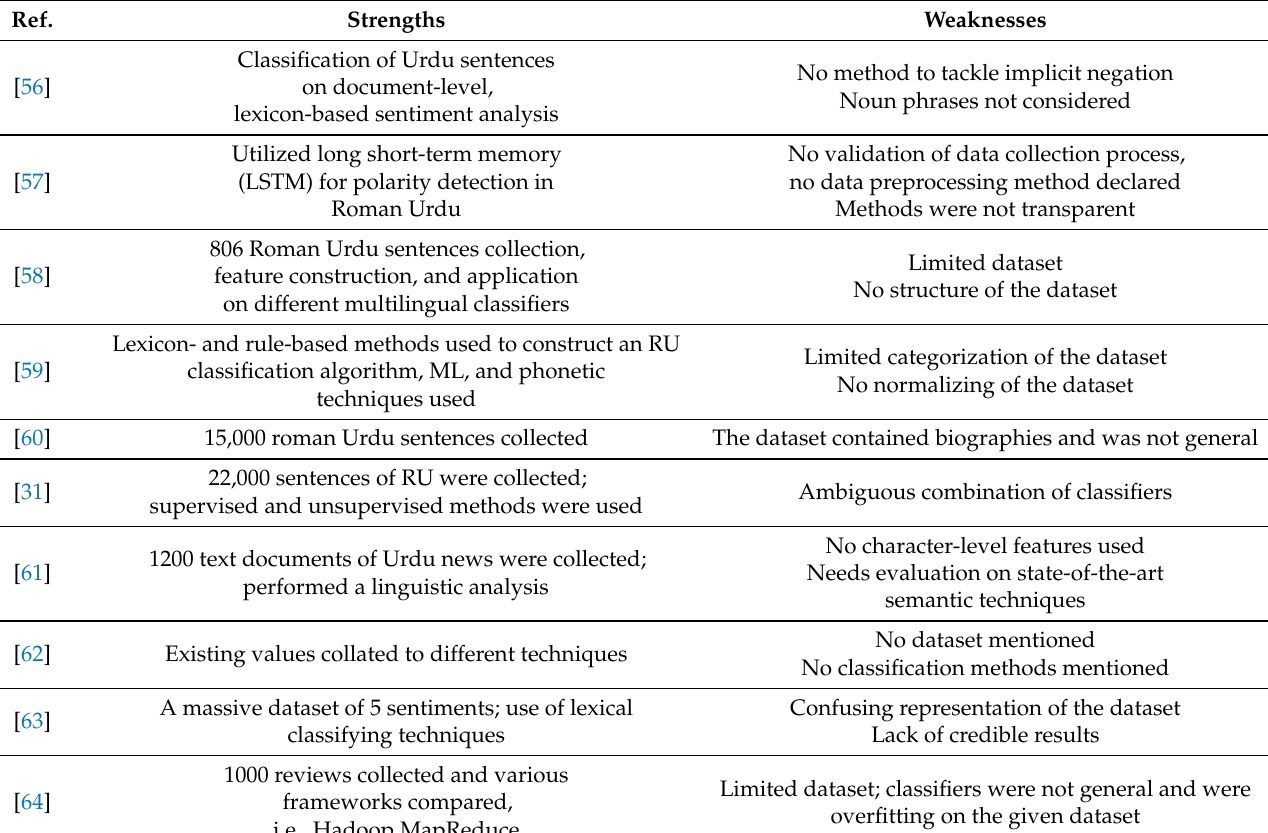
Table 3. Analysis of studies on the classification of Urdu and Roman Urdu hate speech.